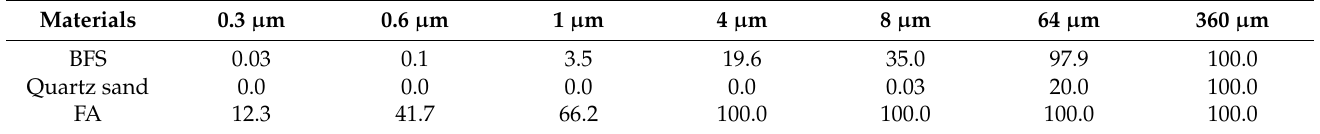
Table 1. Particle passing percentage of raw materials (%).